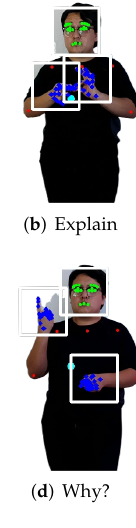
Figure 3. Facial, hands, and body keypoints for the signs representing the words: ( a ) Thank you, ( b ) Explain, ( c ) Where? and ( d ) Why?